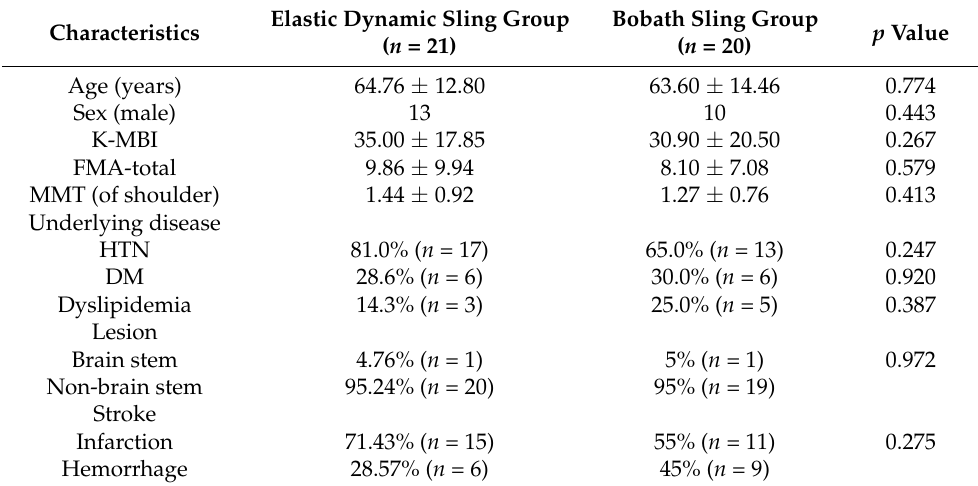
Table 1. Baseline characteristics of the elastic dynamic sling group and the Bobath sling group (mean ± standard deviations).